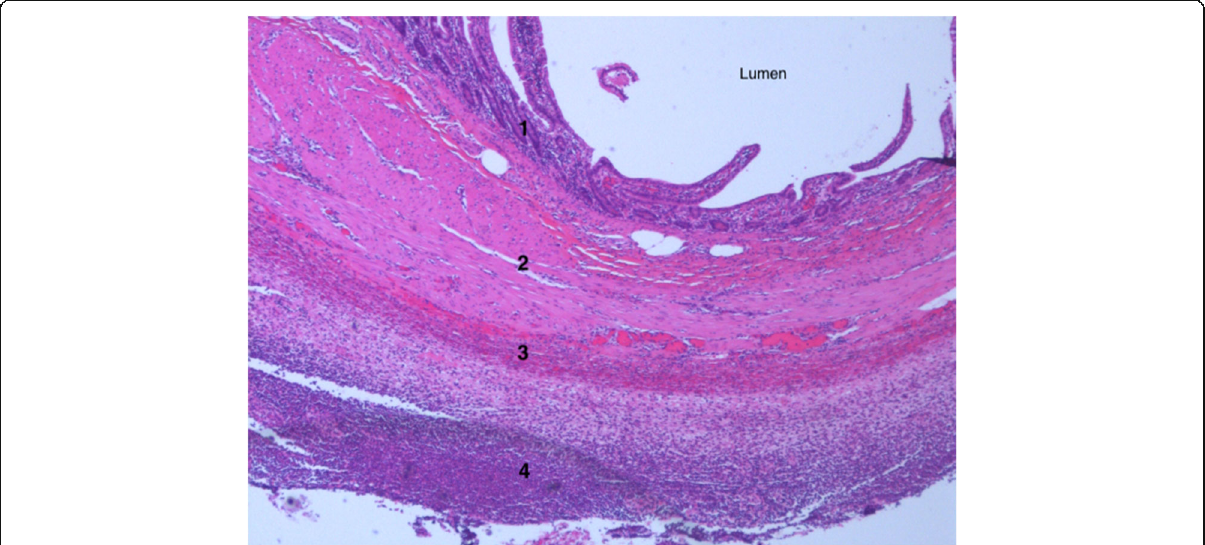
Fig. 6 Low power photomicrograph of the diverticulum immediately adjacent to the site of perforation with layers of mucosa (1), submucosa (2), muscularis propria (3) and acute serositis of the adventitia